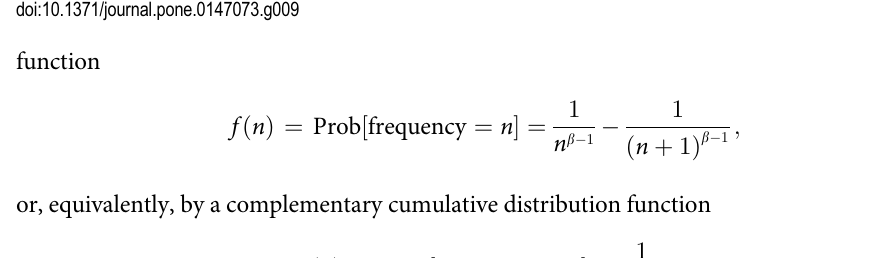
Fig 9. Estimated probability density of β for fits with p (cid:2) 0.05, in different length ranges. We have divided both groups of accepted texts into 4 percentiles according to L . As in the previous figure, the normal kernel smoothing method is applied. (a) For distribution f 1 . (b) For distribution f 2